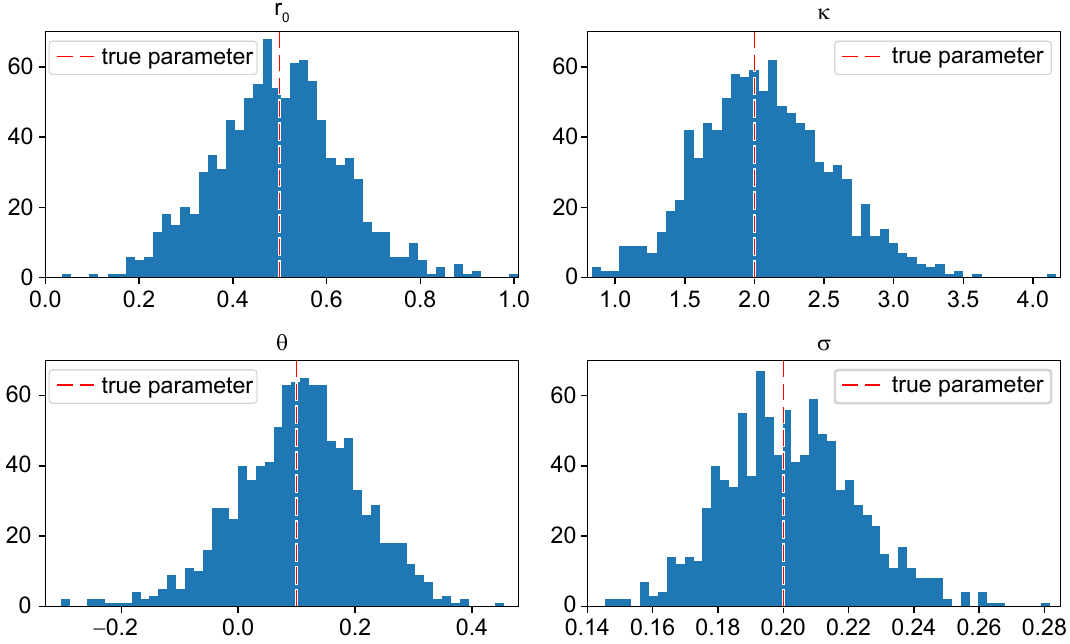
Figure 3. Histogram of the learned parameters obtained with the CG optimizer. Total simulations: 1000.